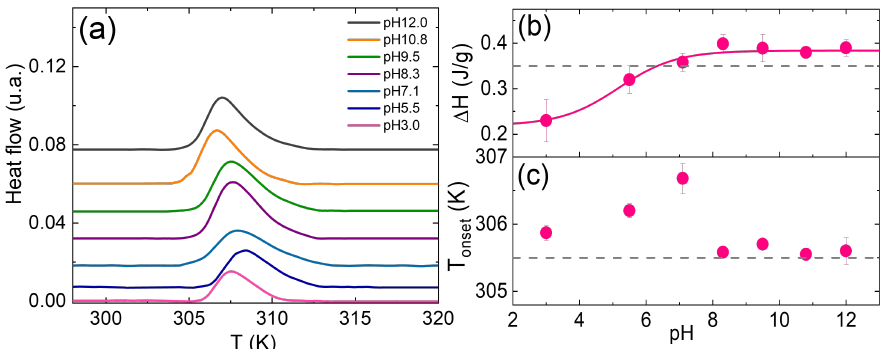
Figure 5. ( a ) DSC thermograms for an IPN microgels with C PAAc = 15.4%, C w = 1.0% at different pH and at heating rate 10K/min. ( b ) Area normalized by mass as a function of pH (pink line is a guide to eyes) and ( c ) Onset temperature. Dashed lines represent the values of pure